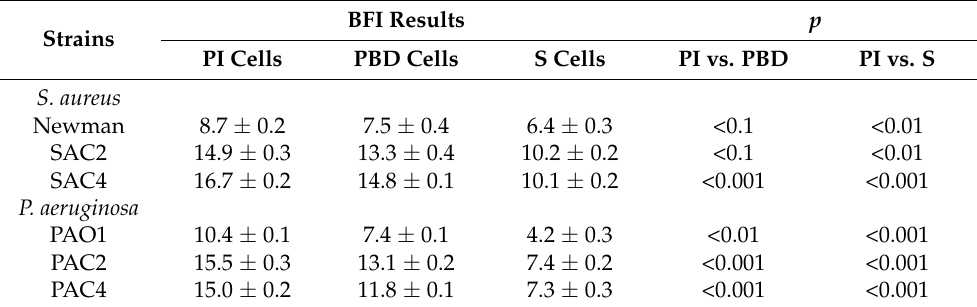
Table 1. Results of BioFilm Ring Test ® assays to evaluate the early biofilm formation of planktonic initial (PI), planktonic biofilm-detached (PBD) and sessile (S) S. aureus and P. aeruginosa cultivated alone in CWM inside the open microfluidic system BioFlux TM 200. The Biofilm Formation Index (BFI) was evaluated after 3-h incubation. Samples were tested in triplicate in two independent experiments. Results are presented as the mean ± standard deviation of three different experiments. Statistics were performed using a t -test on GraphPad Prism version 9.2 to compare planktonic biofilm-detached and sessile cells compared to planktonic initial